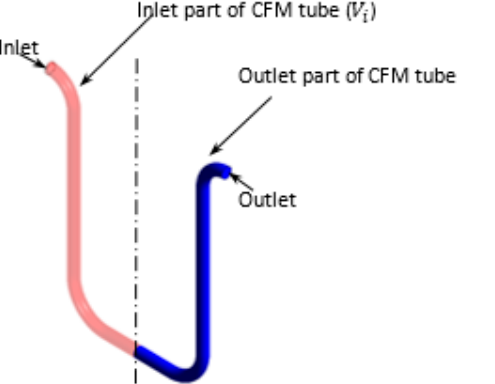
Figure 6. The parts of a CFM tube, which are used for the characterization of gas distribution asym-